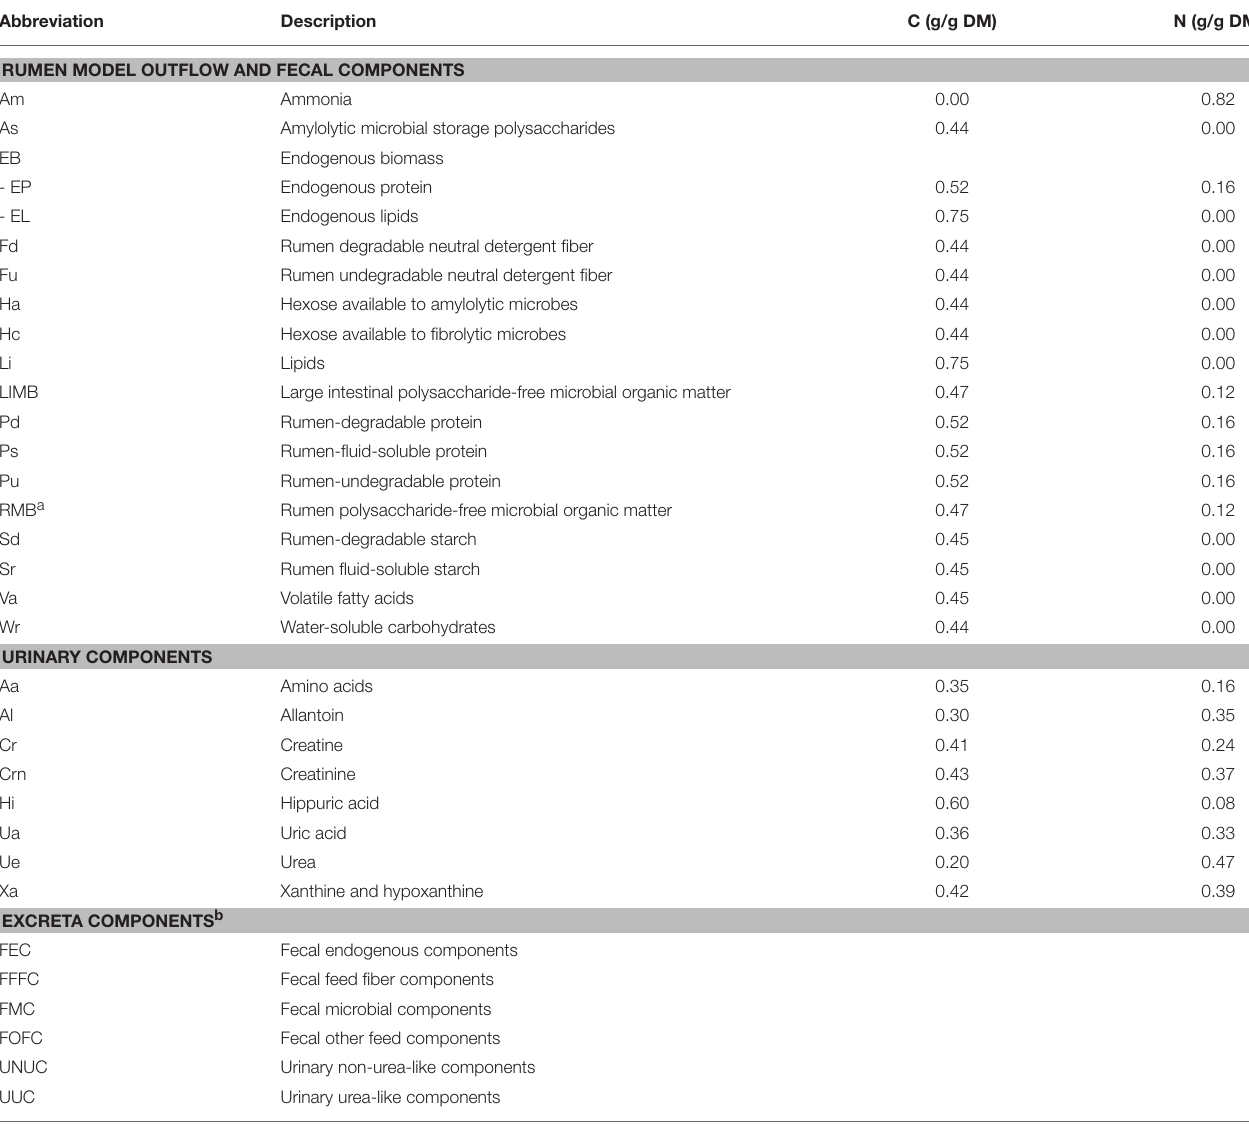
TABLE 1 | Abbreviations used in the model and carbon (C) and nitrogen (N) contents (in dry matter, DM) of